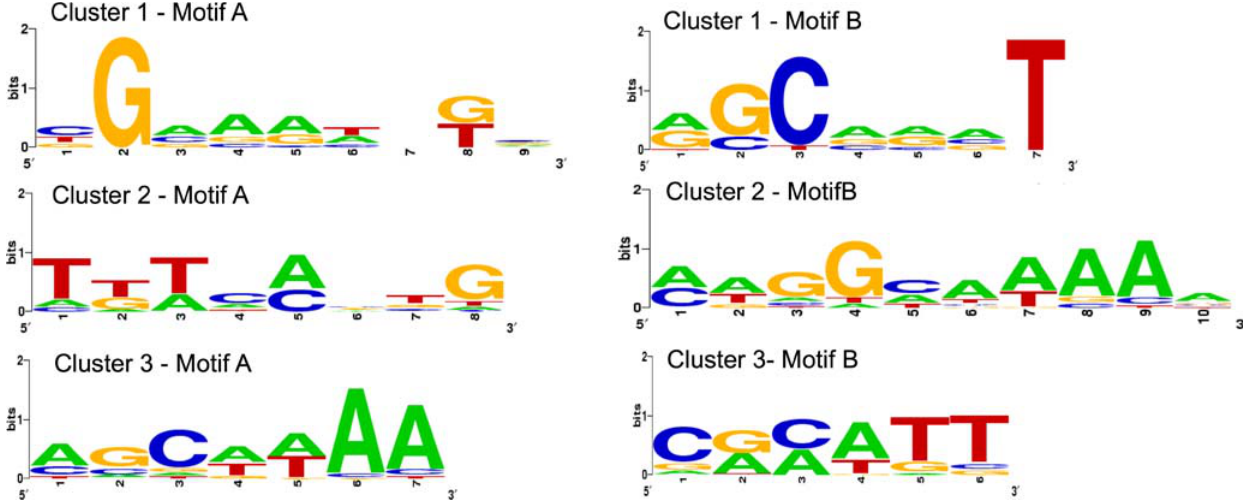
Figure 8. Significant two-block motifs in SoxR-dependent clusters. The two block algorithm implemented in Bioprospector finds a motif with two blocks separated by a variable length gap. The median gap for cluster 1 is 7 with a range of 5 to 9. The median gap for cluster 2 is 6 with a range of 4 to 8. The median gap for cluster 3 is 6 with a range of 5 to 8.